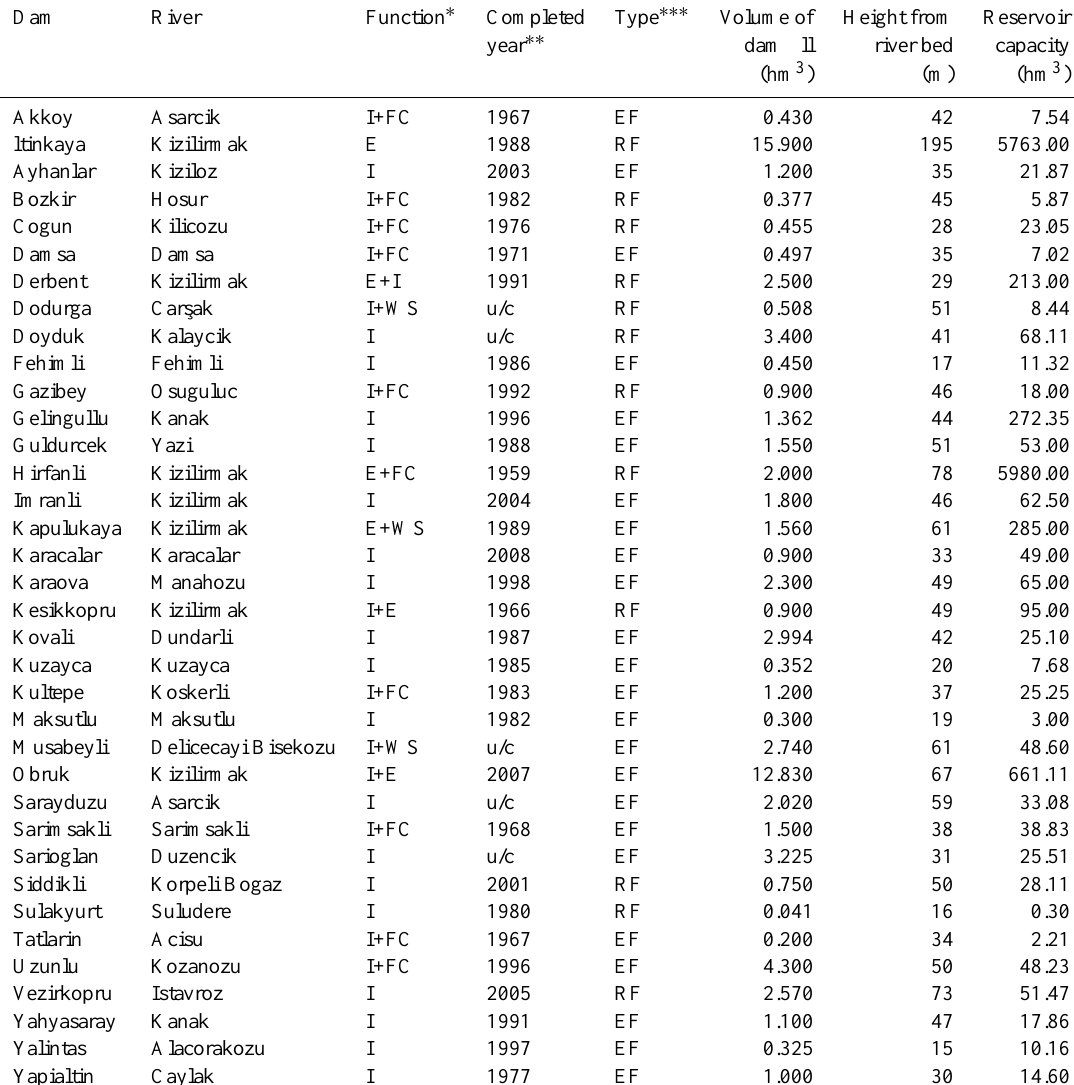
Table 1. Properties of large dams considered for this